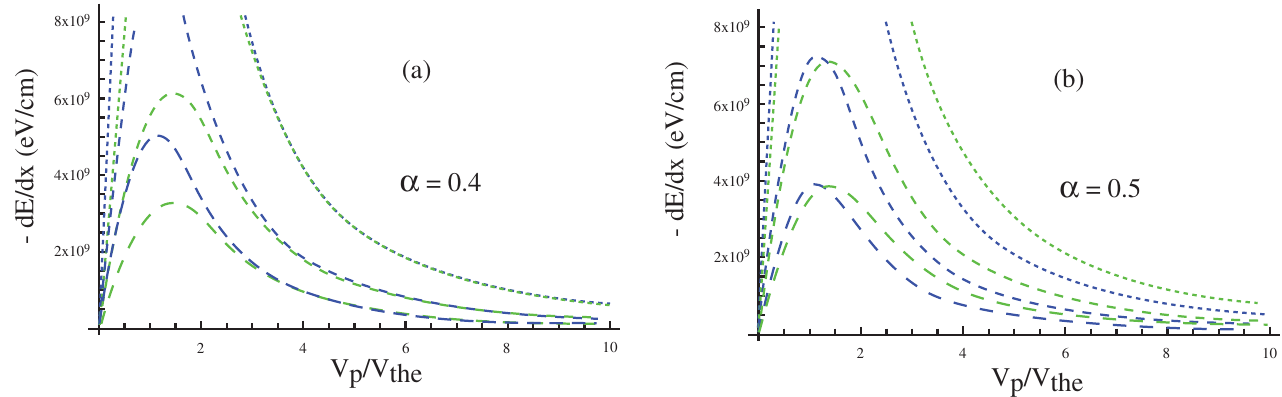
FIG. 3. (Color) Proton particle projectile in a deuterium-tritium BIM with n e ¼ 10 26 e cm (cid:1) 3 and temperatures ¼ ( ) 1 keV, ( ) 2 keV, ( ) 10 keV, with D þ relative proportion: (a) (cid:1) ¼ 0 : 4 and (b) (cid:1) ¼ 0 : 5 . Dark gray (red) refers to electron stopping, light gray (green) to D þ stopping, and black (blue) denotes T þ stopping, (cid:1) dE=dx ( eV = cm ) in terms of V p =V the .